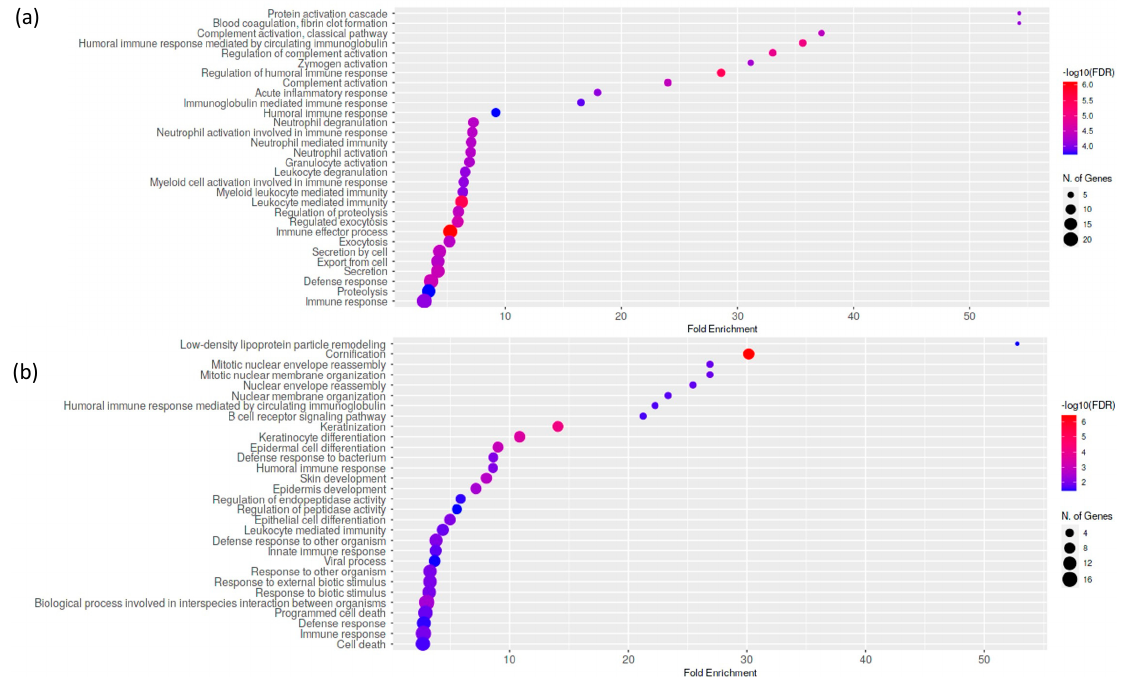
Figure 2. Deregulated biological processes. ( a ) Up in MIH based on GO biological processes. ( b ) Down in MIH based on GO biological processes. Table 2. Selected deregulated proteins with information on statistical significance ( p values), expres- sion (ratio MIH/Control), and function.